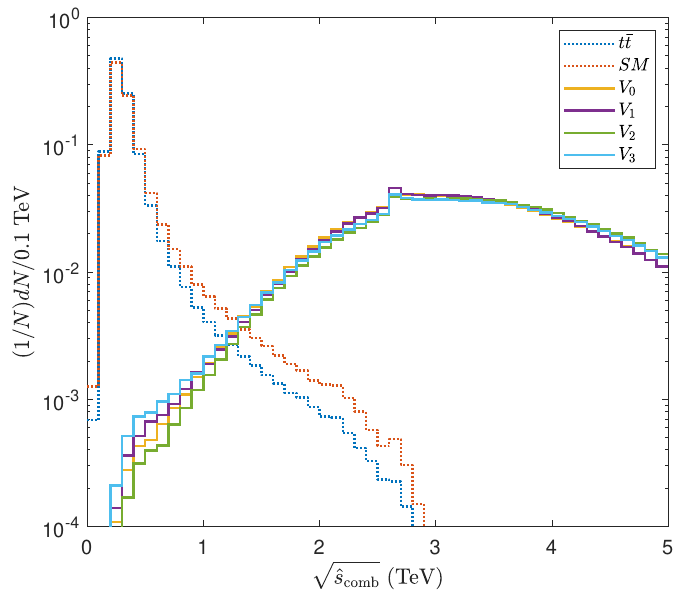
√ ˆ s comb for the signal events and background events.